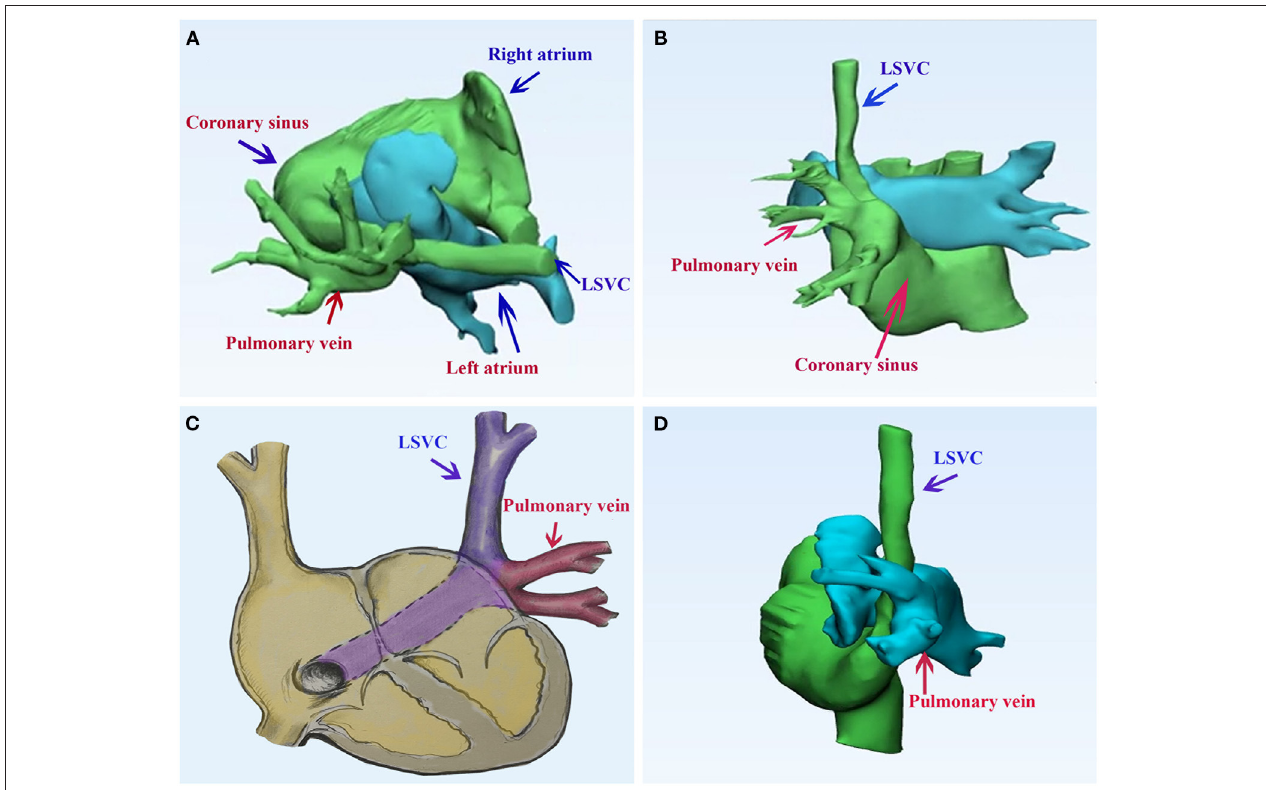
FIGURE 1 | Pulmonary computed tomography of the case of persistent left superior vena cava draining into the right atrium via the coronary sinus, while the left superior pulmonary vein returns abnormally to the coronary sinus. (A,B) The 3-dimension model of the congenital heart disease; (C) a diagram of the case; (D) the postoperative 3-dimension model of the double-decker technique. LSVC, left superior vena